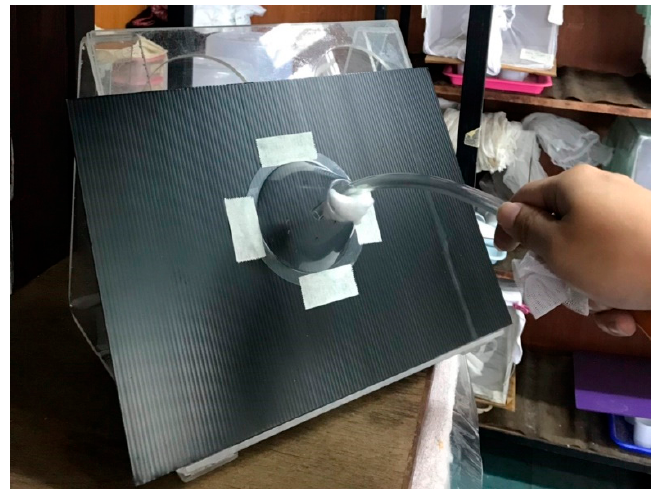
Figure 1. Cone bioassay.